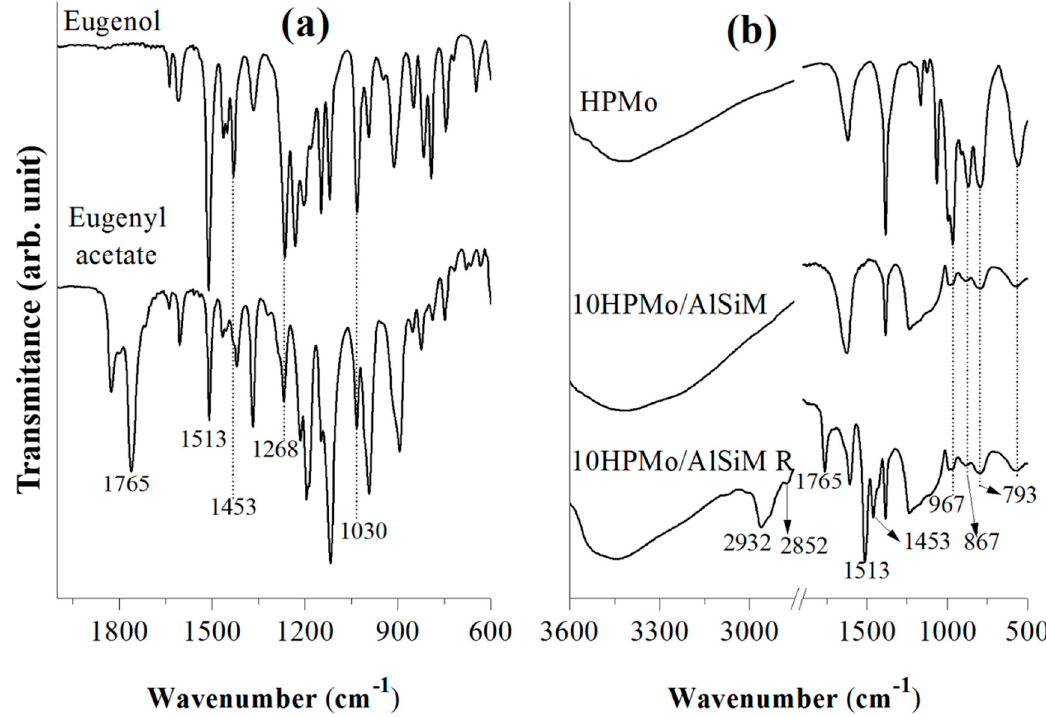
Figure 13. FTIR spectra for eugenol, eugenyl acetate ( a ) and 10HPMo/AlSiM and 10HPMo/AlSiM R (where R = reused) ( b ).